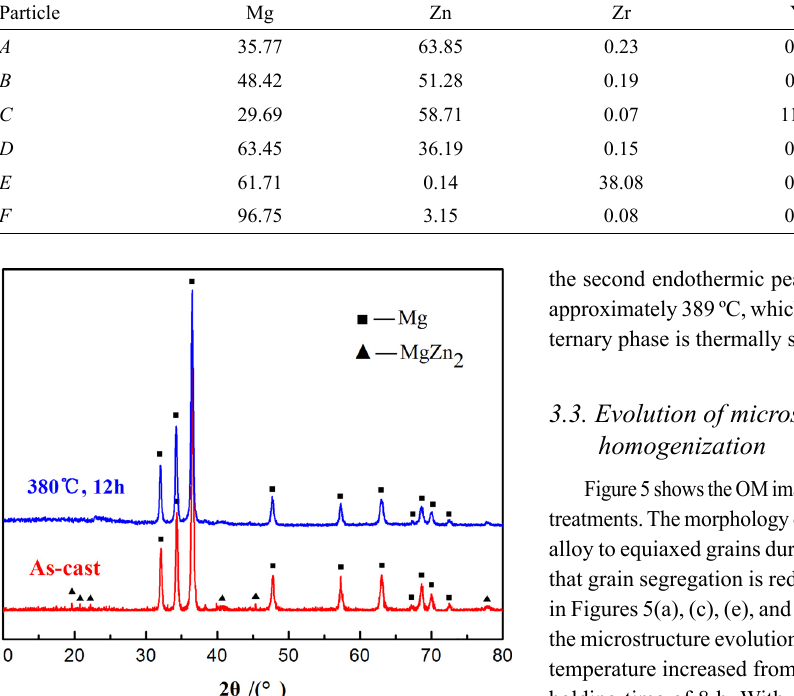
Figure 3. XRD patterns of as-cast and homogenized alloys.